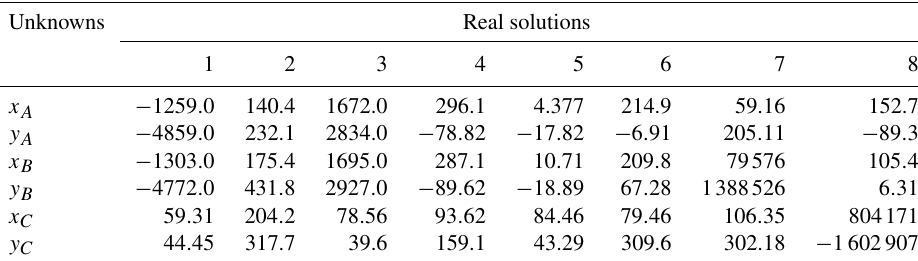
Table 4. Real solutions for the planar 3R serial chains.